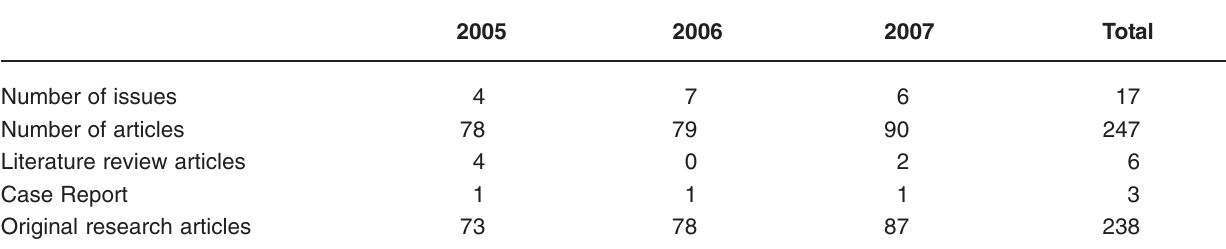
TABLE 2- Number of issues, articles and types of published papers between 2005 and